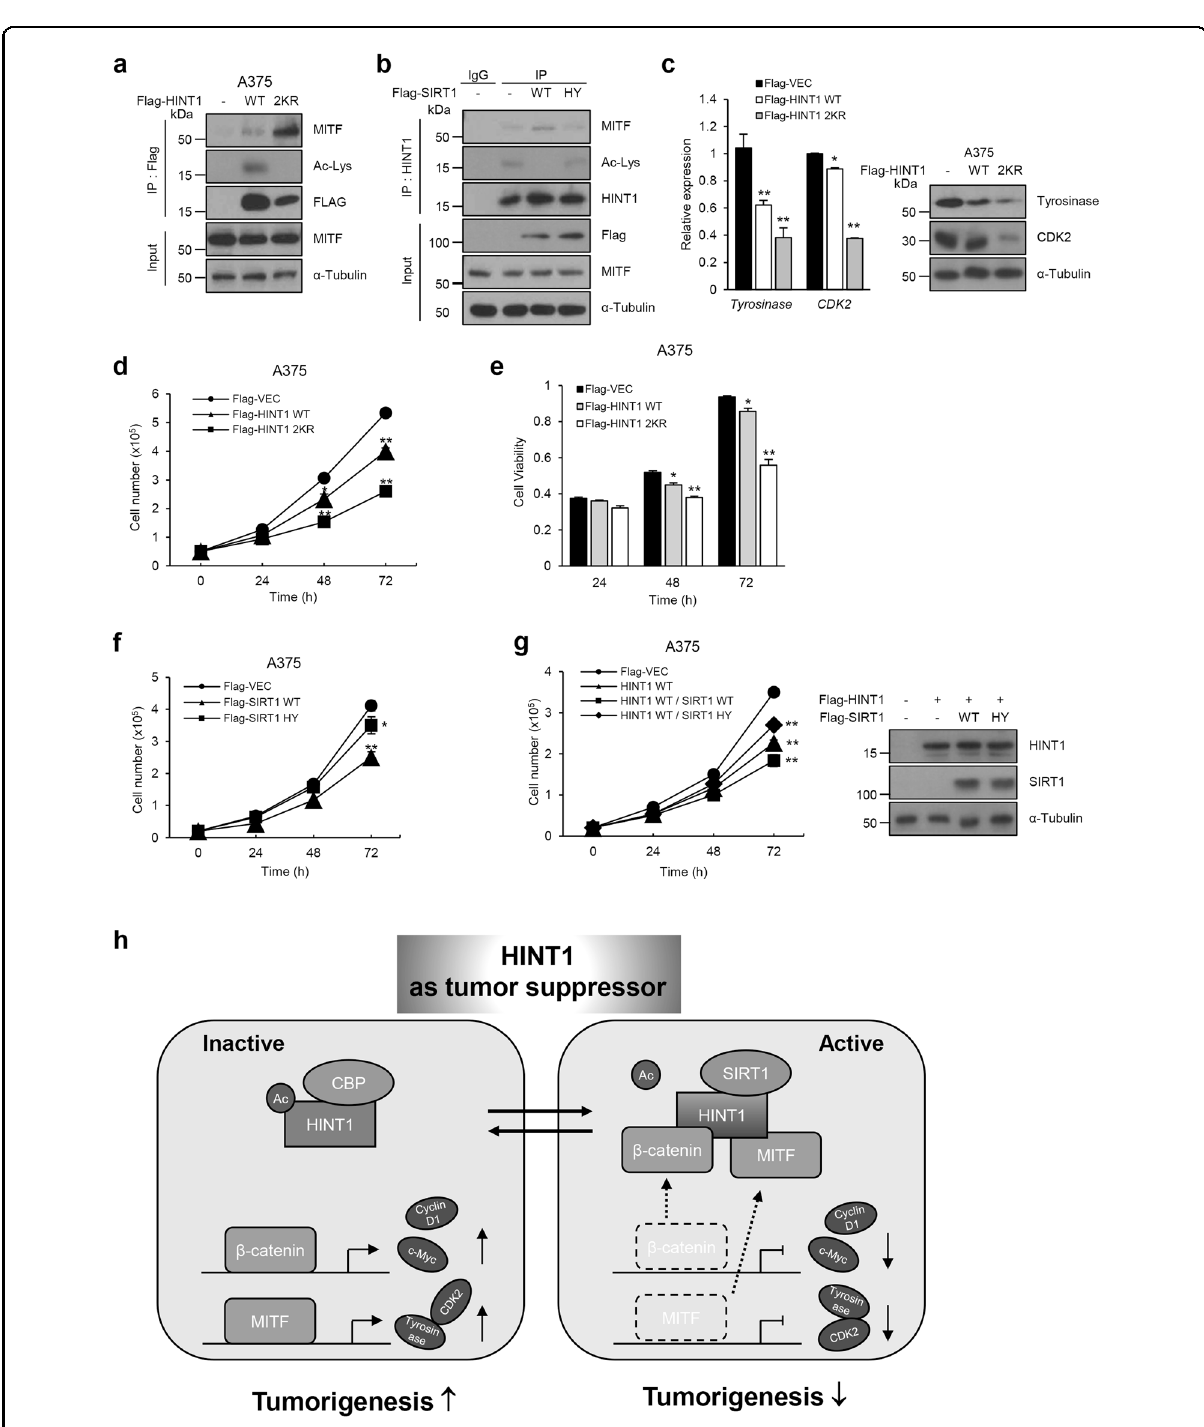
Fig. 7 Deacetylation of HINT1 by SIRT1 also promotes its inhibition of MITF to suppress cell growth in A375 cell lines. A375 cells were transfected with Flag-HINT1 WT or 2KR mutant and subjected to IP and western blot assays using antibodies as indicated. b A375 cells were transfected with the Flag-SIRT1 WT or HY mutant and subjected to IP and western blot assays using antibodies as indicated. c A375 cells were transfected with Flag-HINT1 WT or 2KR vectors and subjected to qRT-PCR, and western blot assays to determine the mRNA and protein levels of tyrosinase and Cdk2. d , e A375 cells were transfected with Flag-HINT1 WT or 2KR vectors followed by cell counting ( d ) and MTS assay ( e ) at the indicated times. f Flag-SIRT1 WT or HY was expressed in A375 cells, and then cell counting was performed to determine cell proliferation rates. g Flag-SIRT1 WT or HY constructs were cotransfected with the HINT1 WT construct in A375 cells, and then cell counting was performed to determine cell proliferation rates, and western blotting was performed to con fi rm the expression levels of expression vectors as indicated. h Proposed model depicting how reversible acetylation of HINT1 by SIRT1 and CBP regulates its tumor- suppressive activity in cancer cells. All data are the mean±SEM of three independent experiments. * P <0.05, ** P